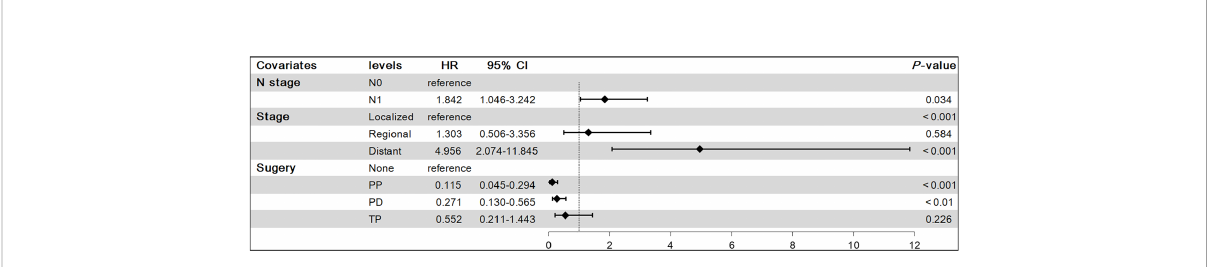
FIGURE 5 Results of multivariate Cox proportional hazards model on cancer-speci fi c survival (CSS). PP, Partial pancreatectomy; PD, Pancreatectomy and duodenectomy; TP, Total